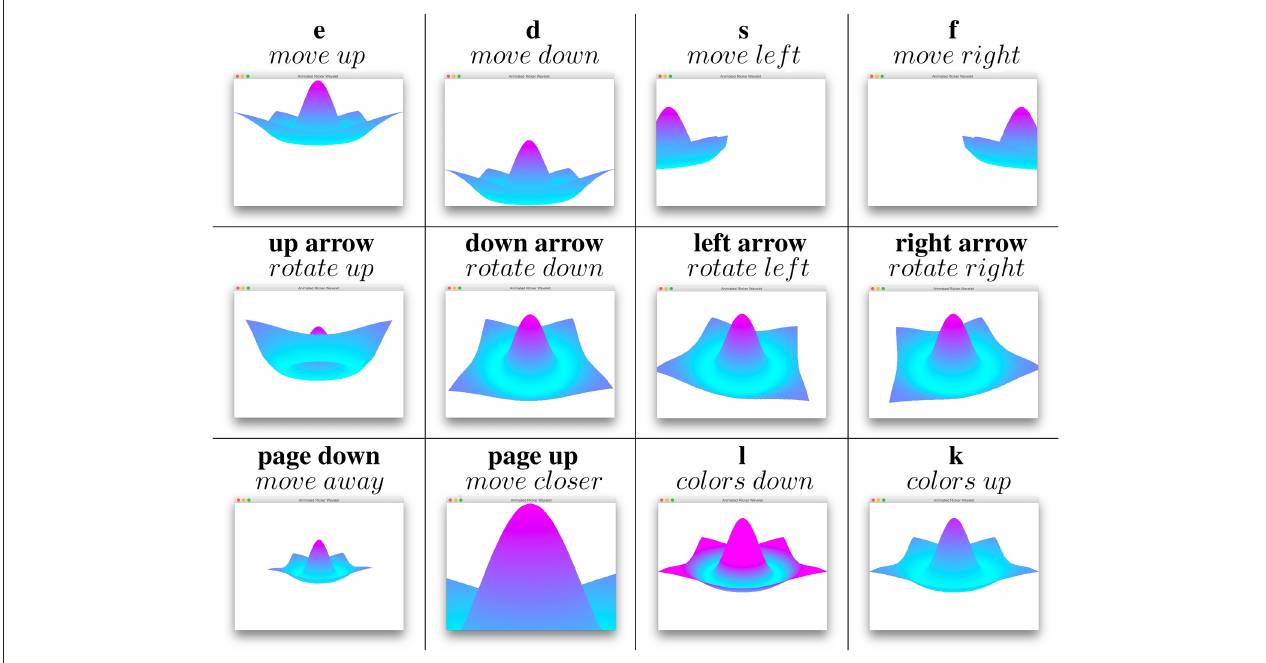
FIGURE 2 | Keyboard keys and their corresponding